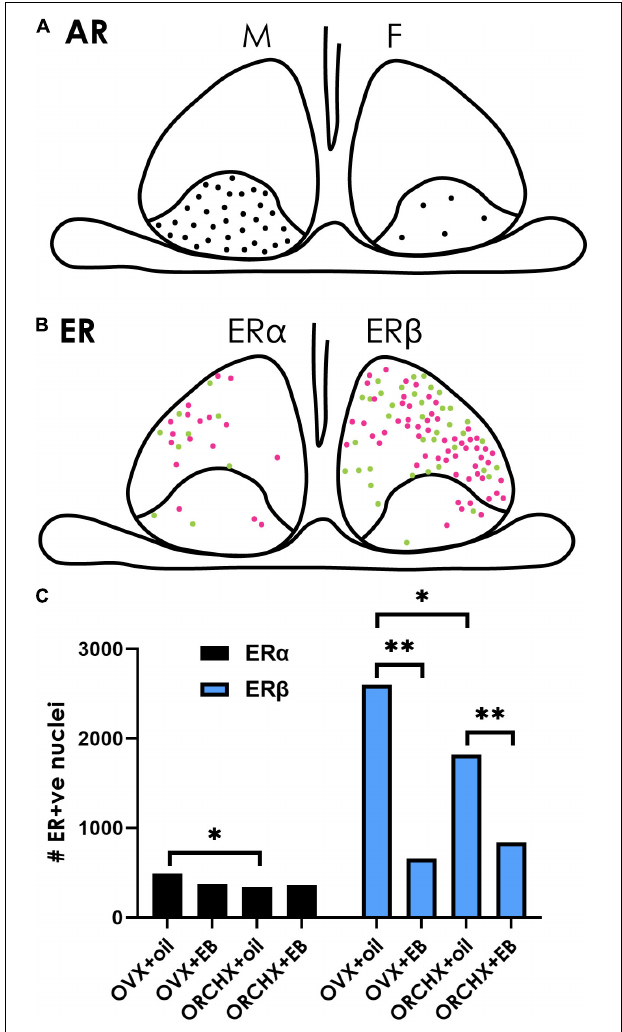
FIGURE 5 | Sex hormone receptors in the SCN. (A) The cartoon depicts the localization of androgen receptors (ARs) in males and females. ARs are restricted to the SCN core, and their density is greater in males (left) than in females (right). Data from Karatsoreos et al. (2007). (B) ERs are mostly localized in the shell SCN in female mice. There are fewer ER α -(left) than Er β - (right) positive neurons. Magenta vs. green dots represent higher vs. lower staining intensity. (C) Quantification of ER in the mouse SCN after gonadectomy with/without estrogen supplement indicates that ovariectomized (OVX) females have higher ER α / β than orchidectomized (ORCHX) males. Images adapted from Vida et al. (2008), with permission from John Wiley and Sons. Symbols: Black bars show counts of ER α . Blue bars show counts of ER β . Single asterisk refers to significant difference between ovariectomized females and oil treated males and ovariectomized and oil treated females. Double asterisks refer to difference between oil and β -estradiol-3-benzoate (EB) treated males or